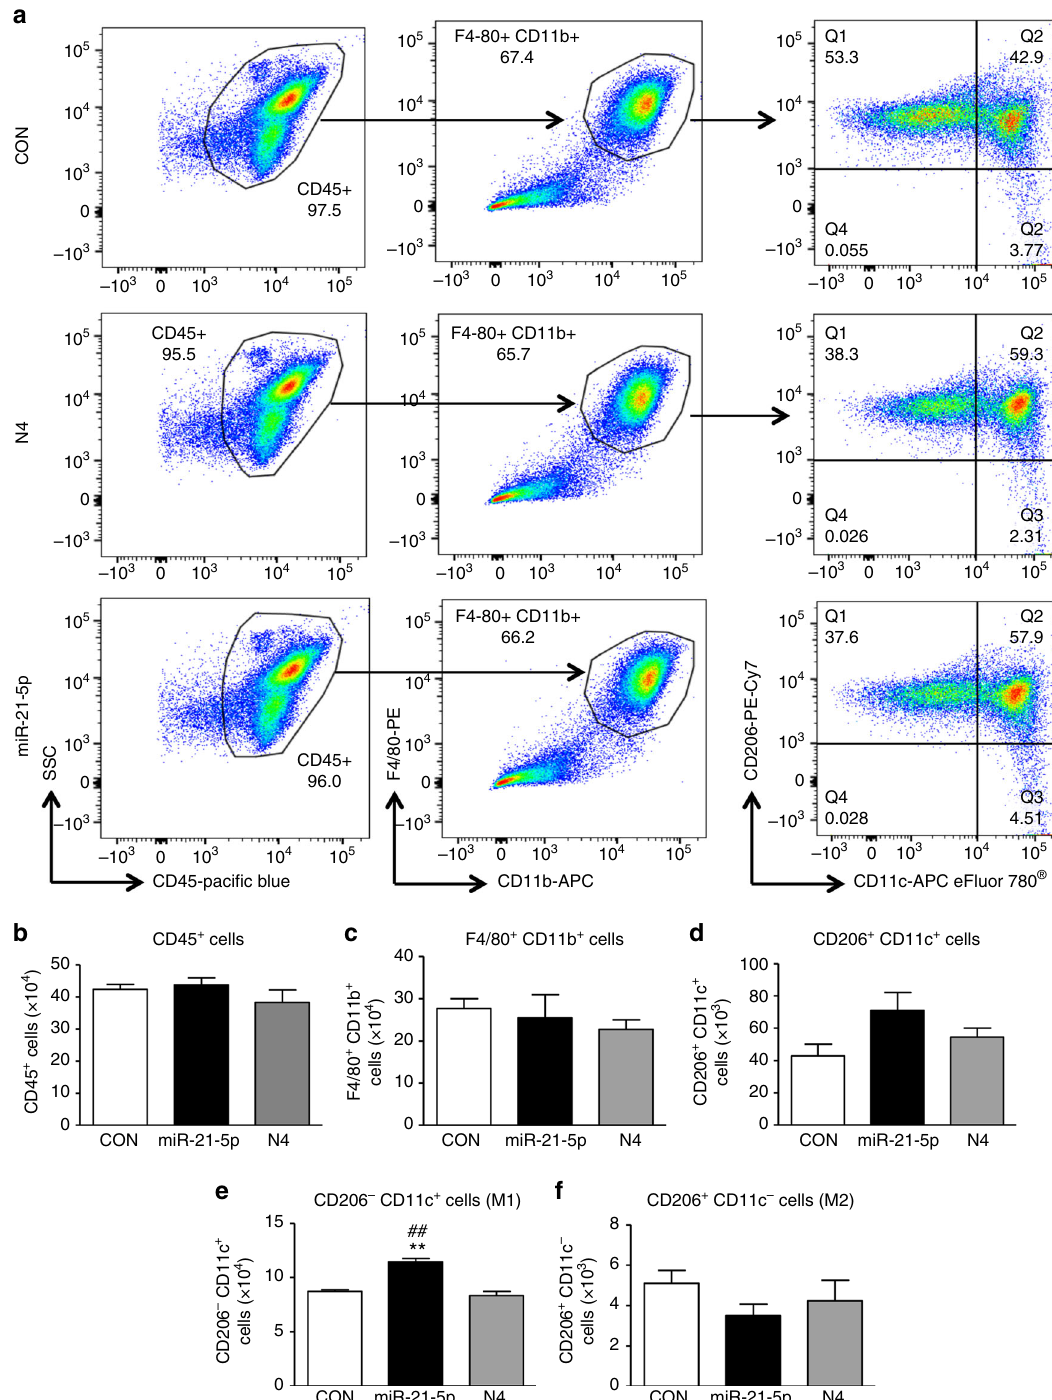
Fig. 7 Transfection of peritoneal macrophages with miR-21-5p mimic reduces M2 and favors M1 phenotype. a Representative scatterplots of peritoneal macrophages transfected with N4 or miR-21-5p mimc for 48 h. Cells were immunolabeled with antibody – fl uorophore conjugates against CD45, CD11b, F4/80, CD206, and CD11c. Macrophages were de fi ned as CD45 + CD11b + F4/80 + cells, and their fl uorescence intensity for CD206 and CD11c labels were used to de fi ne M1 (CD206 − CD11c + ) and M2 (CD206 + CD11c − ) phenotypes. Numbers in gates refer to percentage of positive cells for each speci fi c marker. b – f Bar charts represent numbers of leukocytes (CD45 + cells), macrophages (CD11b + F4/80 + ) and (CD206 + CD11c + ), M1 macrophages (CD206 − CD11c + ) and M2 macrophages (CD206 + CD11c − ). Data are means ± S.E.M., n = 4 for each group. ** P < 0.01 compared to CON; ## P < 0.01 compared to N4, one-way ANOVA, post hoc